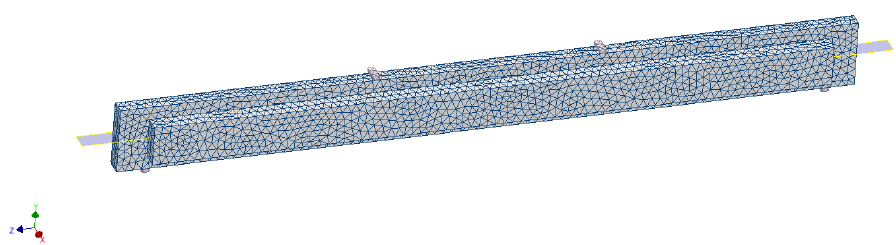
Figure 4. Selected mesh (computational) model of the D version of the short frame made of solid wood material.